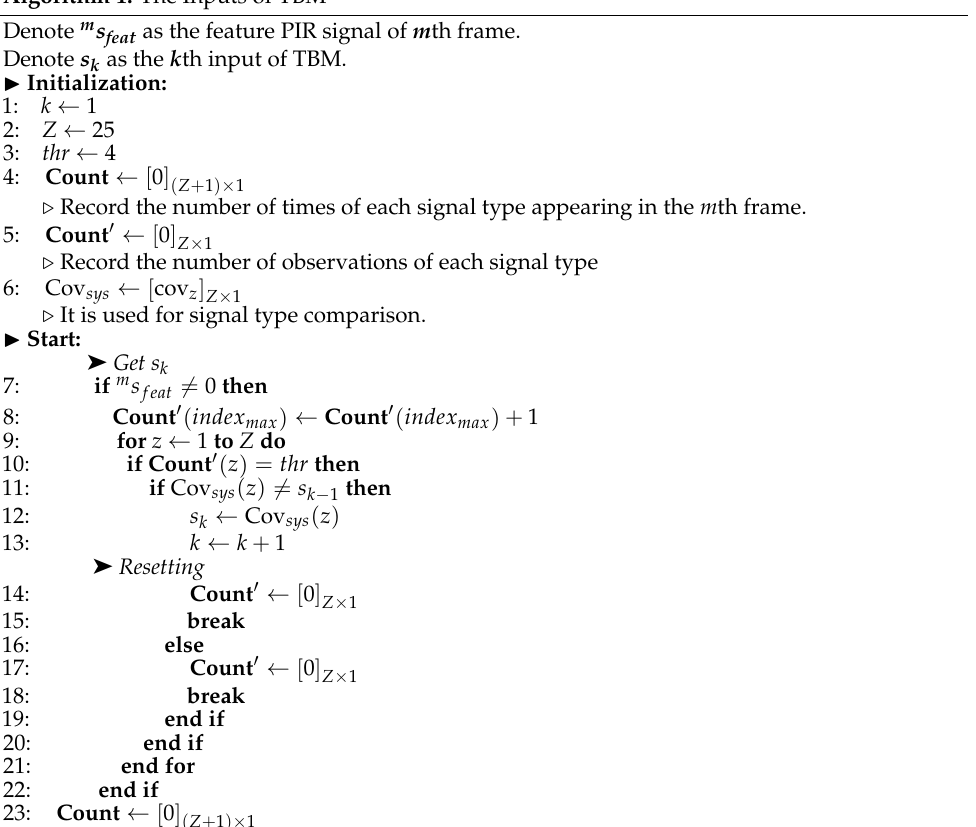
Algorithm 1: The Inputs of